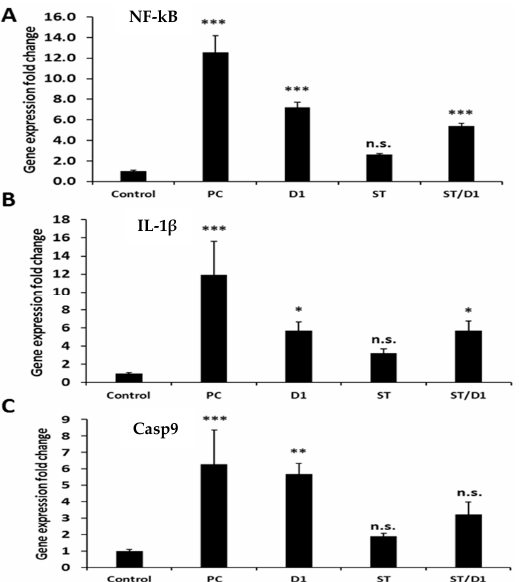
Figure 5. The effect of treated groups (Control, Cisplatin (P.C.), Cisplatin + GGE (D1), Cisplatin + BM-MSCs (St), Cisplatin + BM-MSCs + GGE (St/D1)) on gene expression profiling of the liver in rats. ( A ) NF-kB, ( B ) IL-1 β , and ( C ) Casp9. *** highly significant p < 0.001, ** significant p < 0.005, * significant p < 0.05 and n.s mean non-significant